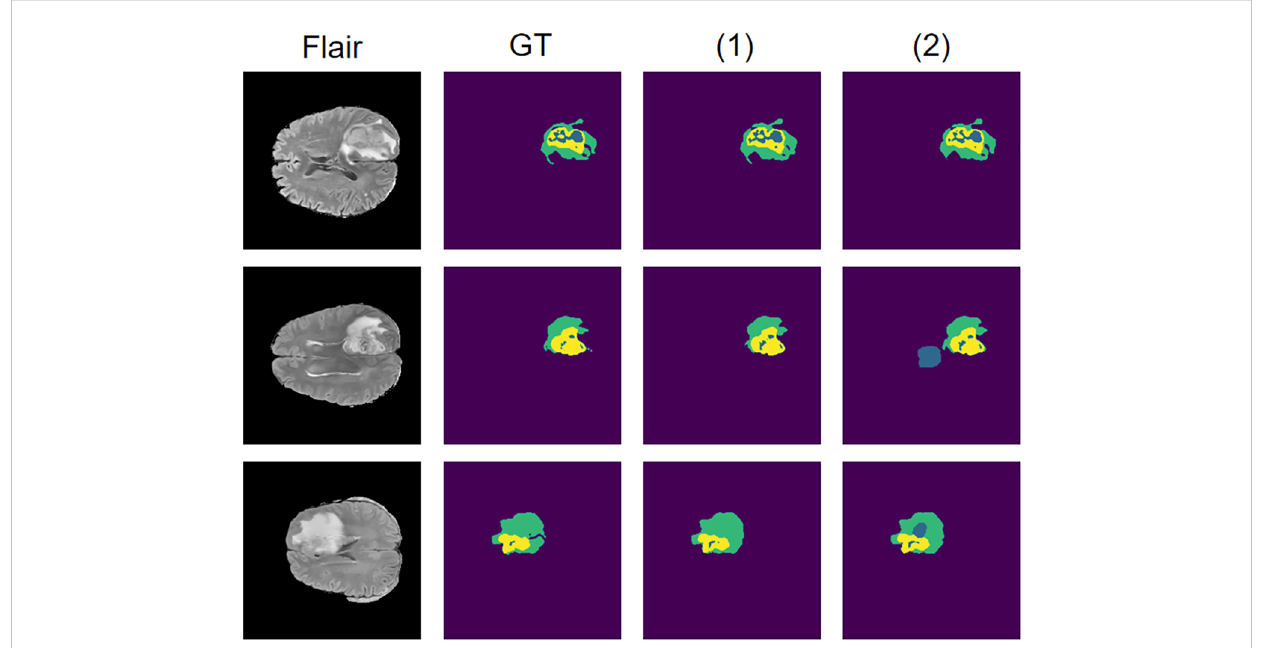
FIGURE 5 Results on the BraTS 2020 dataset using the self-supervised network compared to the network without self-supervision. Where (1) represents the network where the self-supervised training is introduced and (2) represents the network without self-supervised